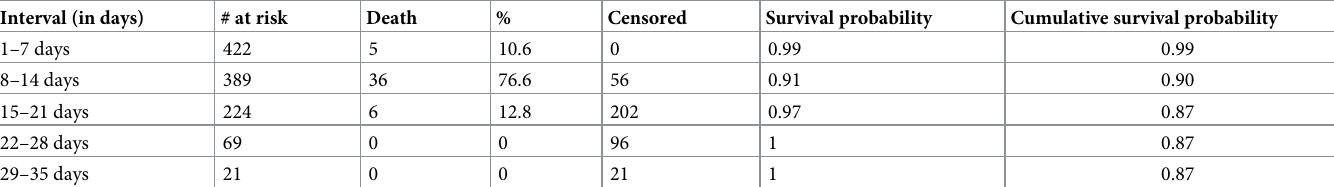
Table 3. Death rate and survival probability of COVID-19 patients hospitalized at Bokoji Hospital treatment centre, Ethiopia, 2021. Interval (in days)